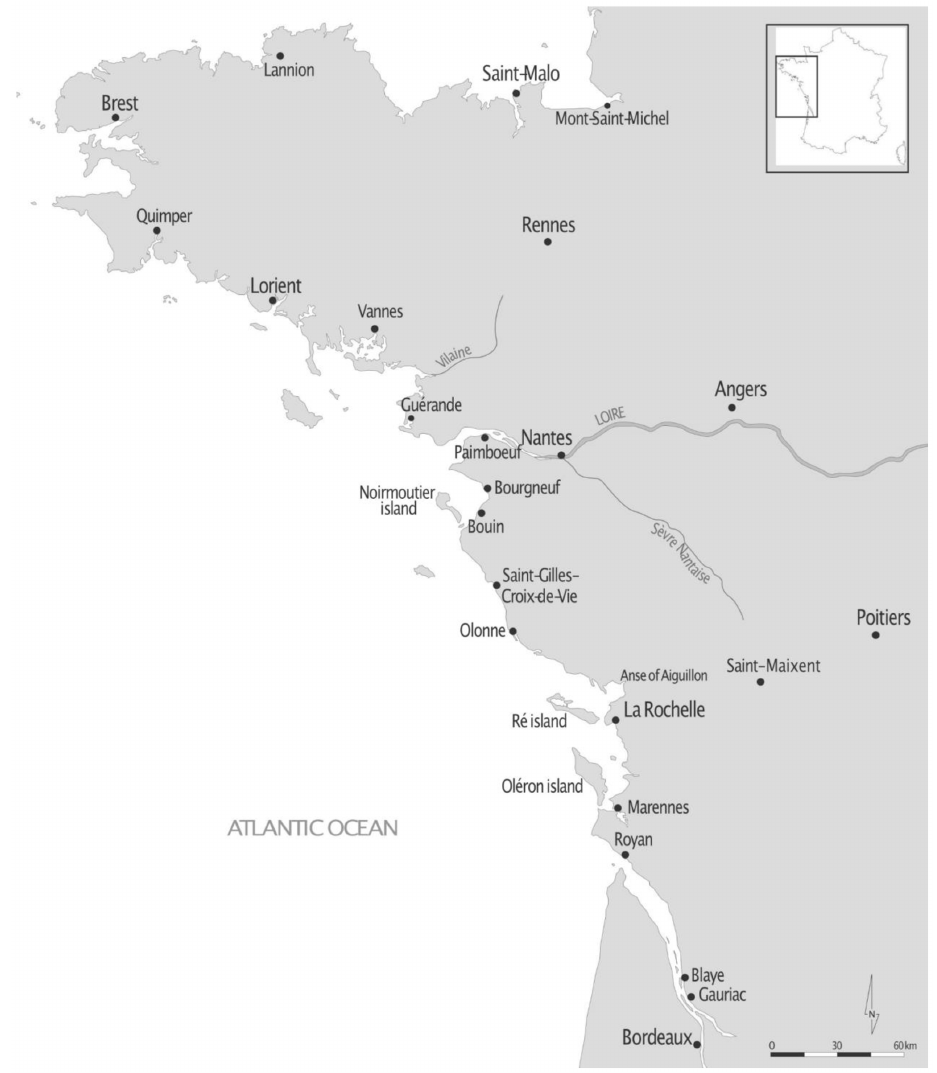
Figure 1. Map of the study